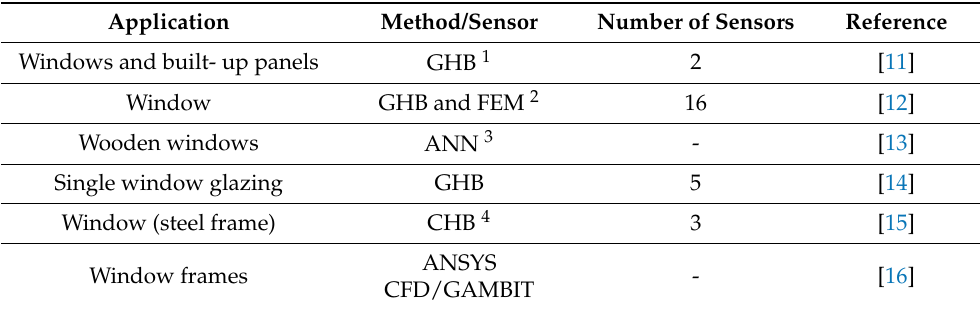
Table 1. Previous studies for deriving the U-value of different types of windows using different